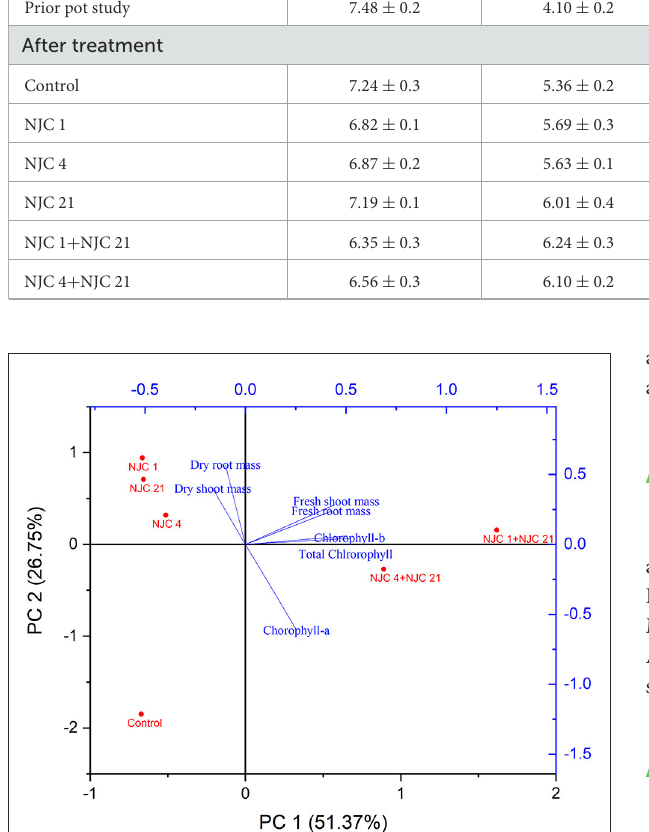
FIGURE9 Principal component analysis (PCA) of growth and yield characteristics of Anethum graveolens L. where NJC 1 - Bacillus sp ., NJC 21 – Serratia marcescens, NJC 4 - Pseudomonas aeruginosa